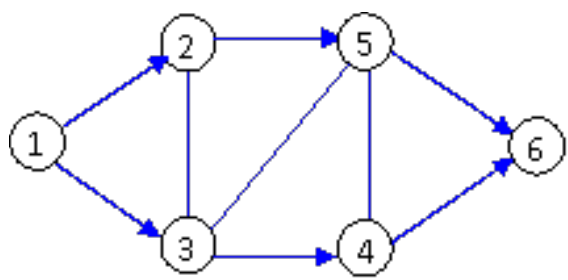
undirected ones.